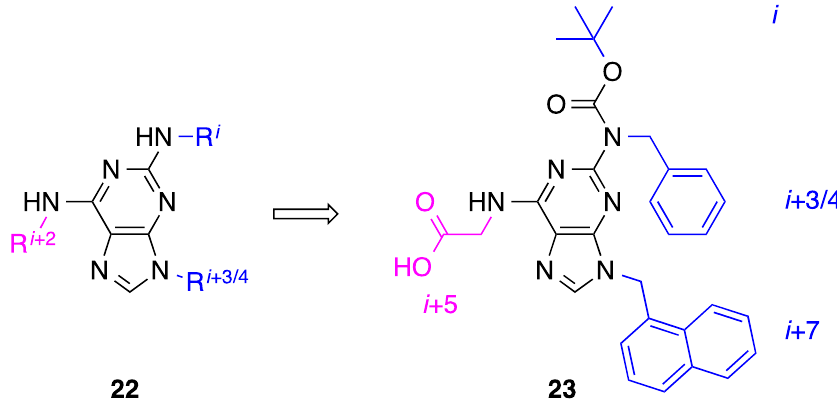
Figure 9. 2,6,9-Tri-substitution of a purine scaffold permits the mimicry of two faces of an α-helix, according to the disruption of the Mcl-1–Bak-BH3